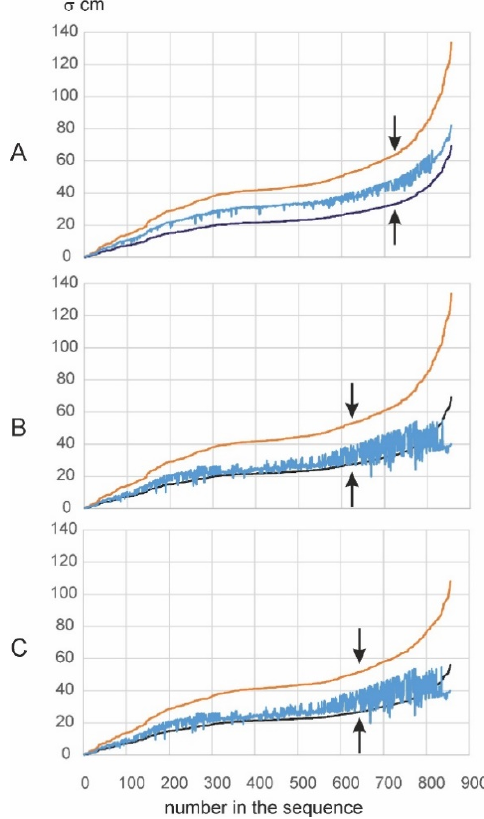
Figure A2. Student’s 10% confidence interval for standard deviation (shown by arrows) for the sequences of annual maximum snow pack depth Hs during the years 1985–2019 with trend ( A ); during the years 1985–2019 with linear trend excluded ( B ) and during the years 1985–2013 with linear trend excluded ( C ). The blue lines show the variation in standard deviation of sequences.